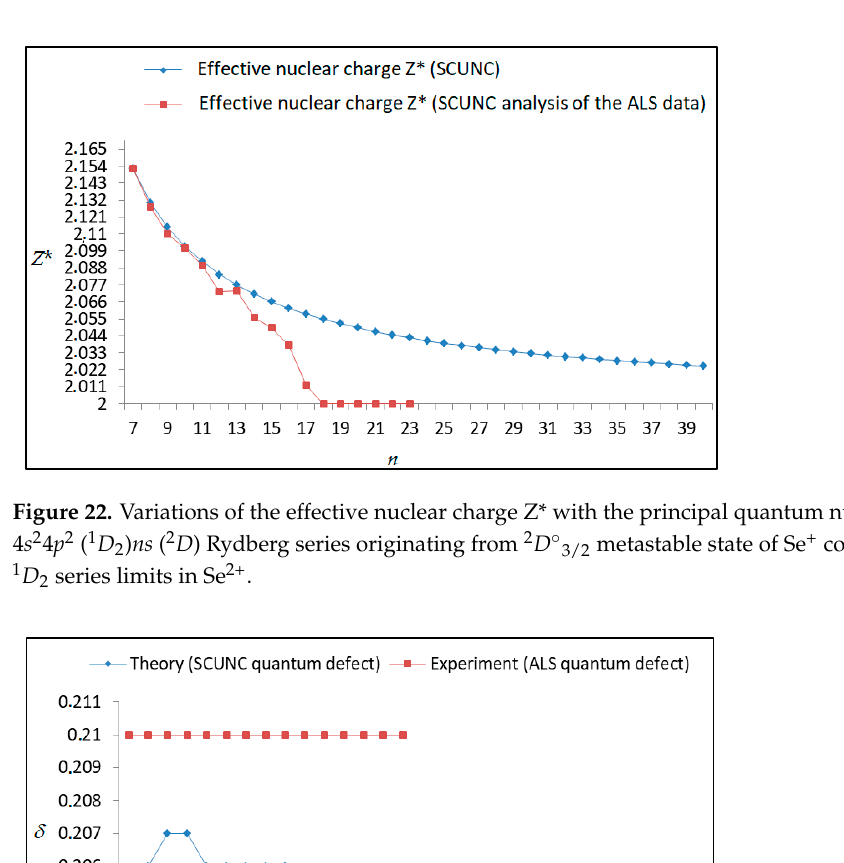
Figure 21. Variations of the quantum defect ( δ ) with the principal quantum number n for the 4 s 2 4 p 2 ( 1 D 2 ) ns ( 2 D ) Rydberg series originating from the 2 D ° 3/2 metastable state of Se + converging to the 1 D 2 series limits in Se 2+ .